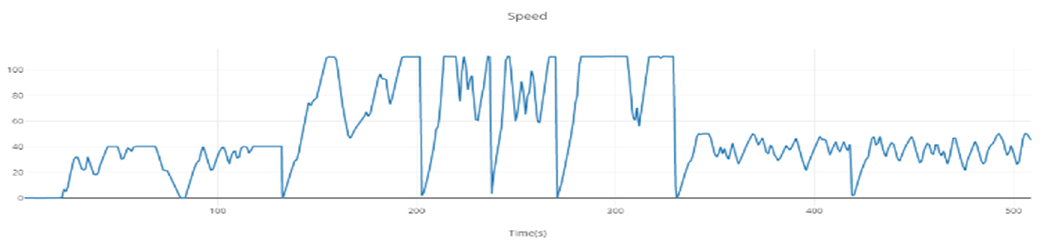
Figure 8. System data—Tracking driving speeds over time.